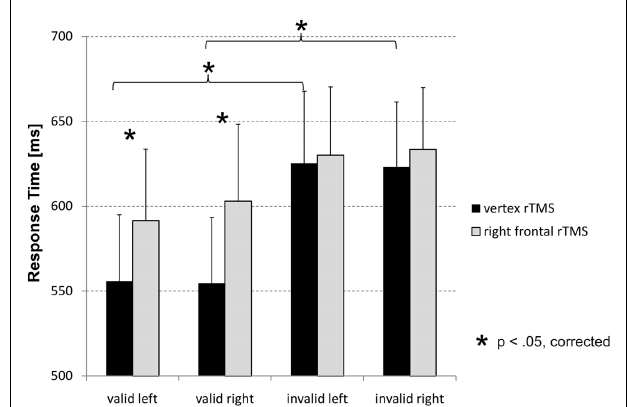
FIGURE 1 | Mean response times as a function of experimental and stimulation condition. Only in valid trials response times were delayed after rTMS at the right FEF compared to stimulation at the vertex (control site).This was the case for trials with the left visual hemi-field attended as well as when attention had been shifted toward the right visual